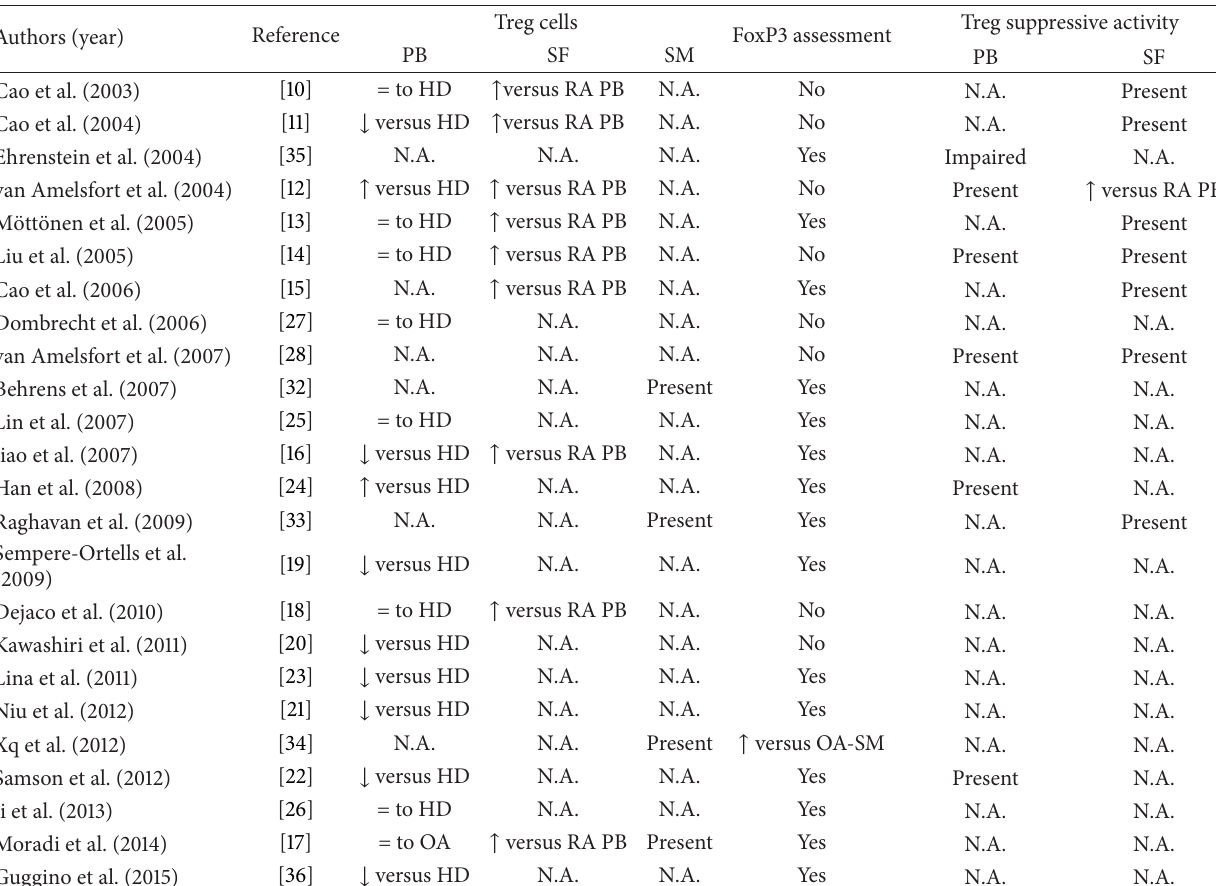
Table 1: Studies assessing regulatory T (Treg) cell number and function in the peripheral blood, synovial fluid, and synovial tissue of patients with rheumatoid